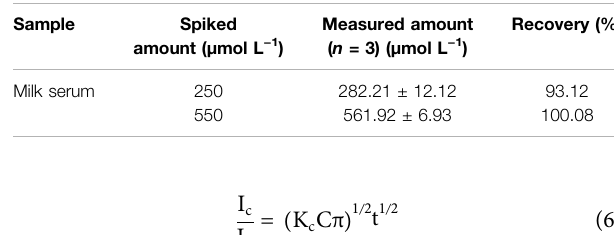
TABLE 5| RecoverydataforH 2 O 2 inspikedmilkserum samplesover aPB-fCNT/ TiO 2 .ZrO 2 (36)500 ° C.20/GC